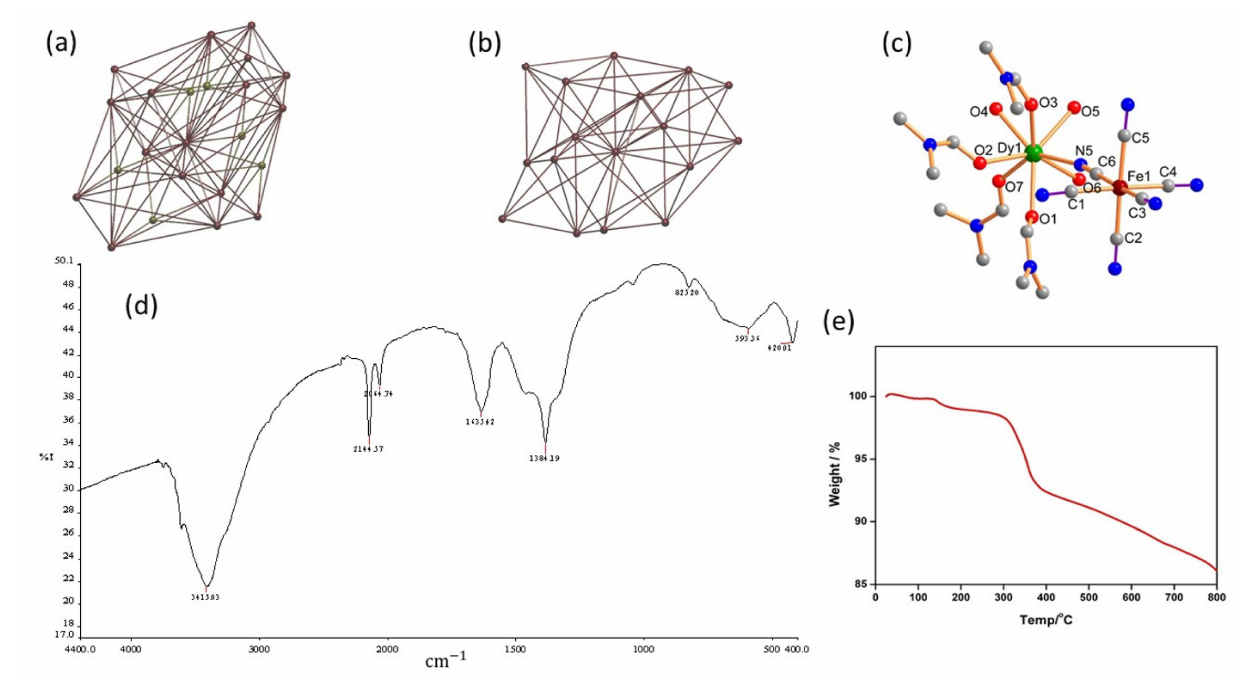
Figure 2. ( a , b ) Underlying net in the standard representation of the Coulomb- or vdW-bonded molecular structures, when considering the uncoordinated H 2 O (left) or not (right). The red spheres describe the molecular complexes; the yellow spheres describe the H 2 O molecules. ( c ) DFT-optimized structures of 1 . H-atoms and H 2 O were omitted for clarity. ( d ) IR spectrum of 1 . ( e ) TGA spectrum of 1